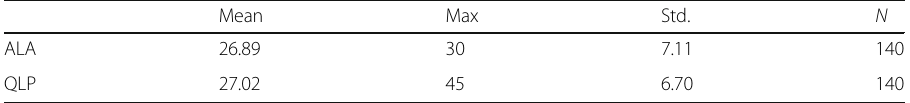
Table 11 Descriptive statistics for academic language abilities and language performance in target domain for the TOEFL iBT test